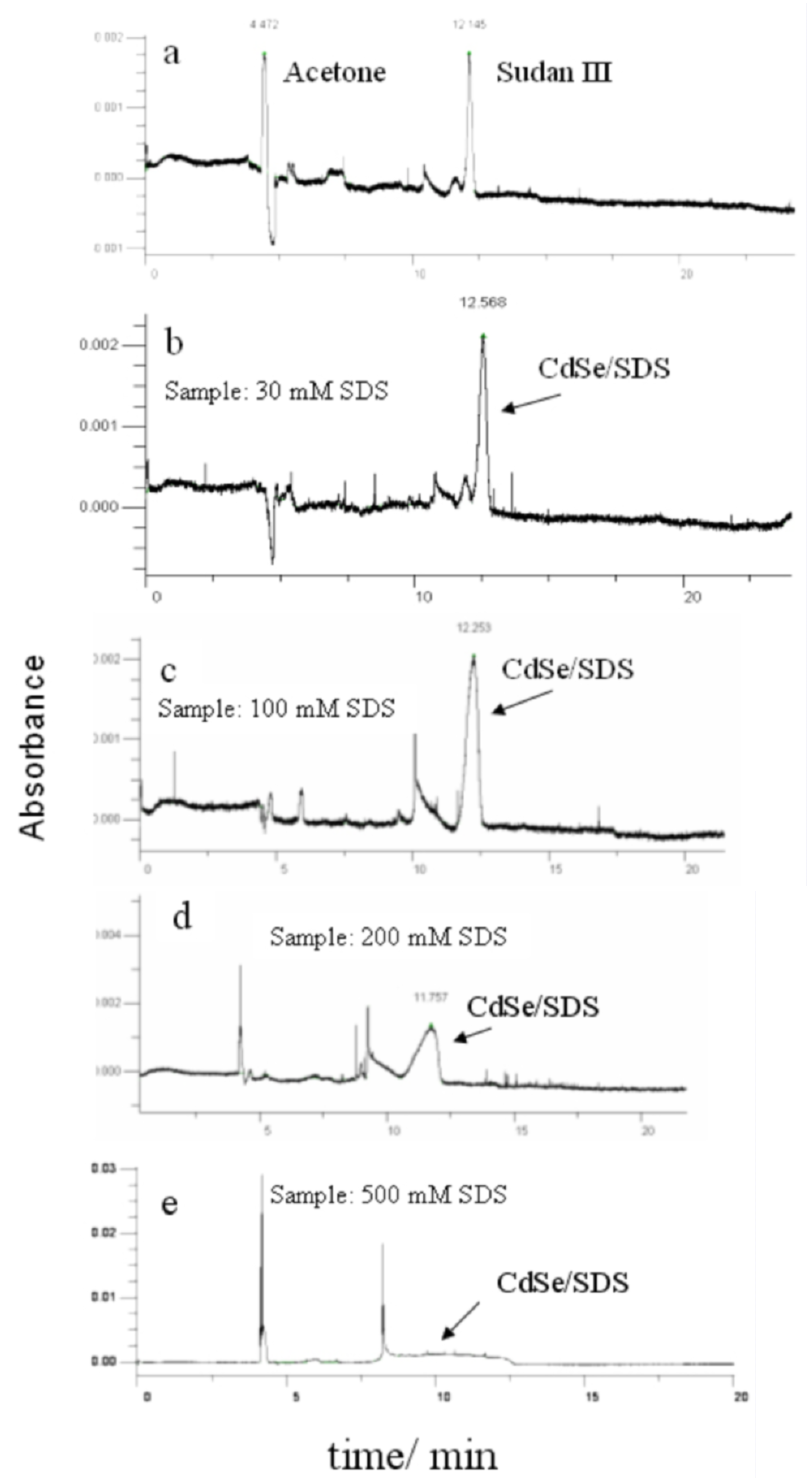
Figure 4. MEKC separation of CdSe/TOPO//SDS QDs at various surfactant (SDS) coating concentrations: (a) migration markers; (b-e) 30 – 500 mM SDS coating concentration. Separation conditions: 50 mM SDS/ 10 mM sodium tetraborate, applied voltage +20